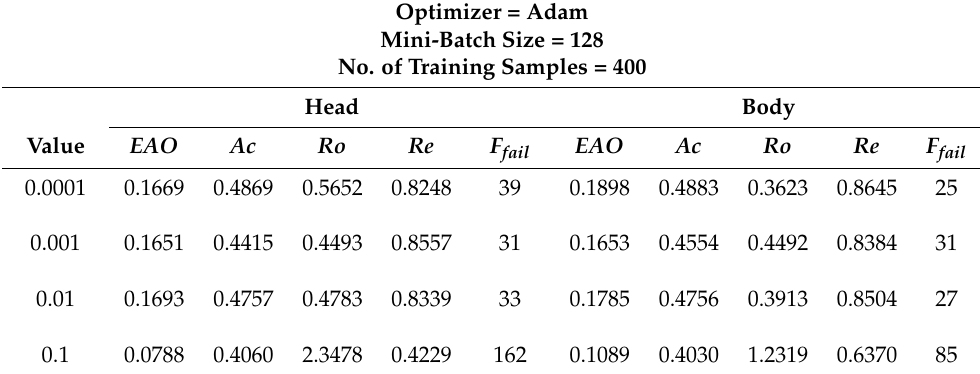
Table 6. Performance evaluations of the learning rate configurations.